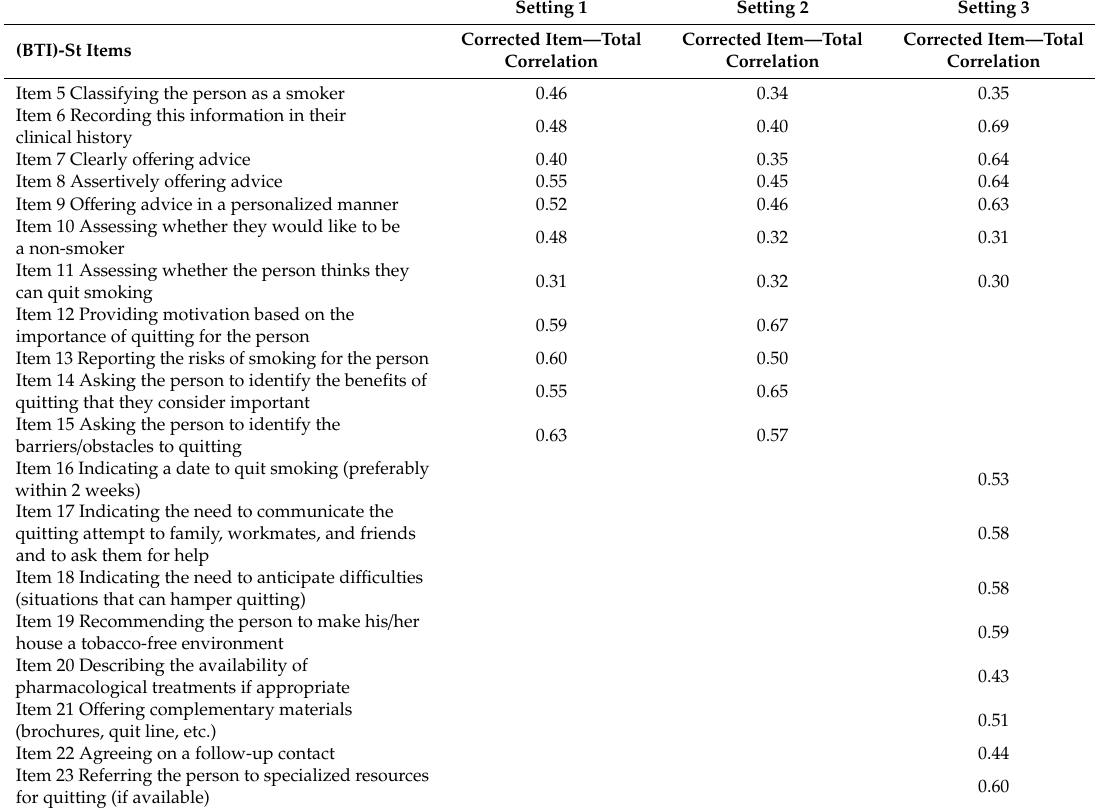
Table 1. Results of discrimination analysis of brief tobacco intervention (BTI)-St items in the three